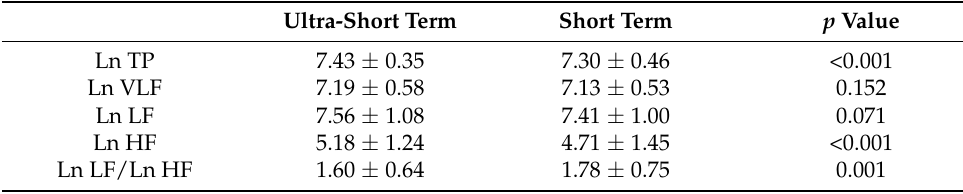
Table 3. Heart rate variability parameters between ultra-short and short term in moderate obstructive sleep apnea.